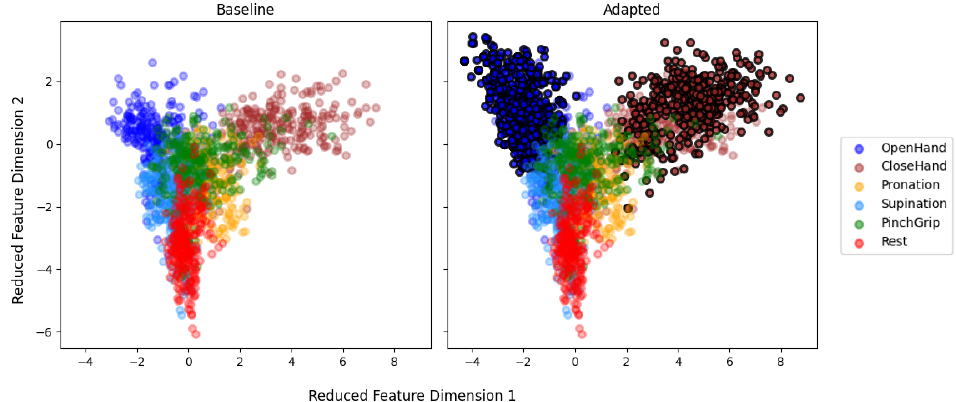
Figure 19. Reduced feature map before adaptation ( left ) and after ( right ) for subject 1. Adapted samples are marked with black